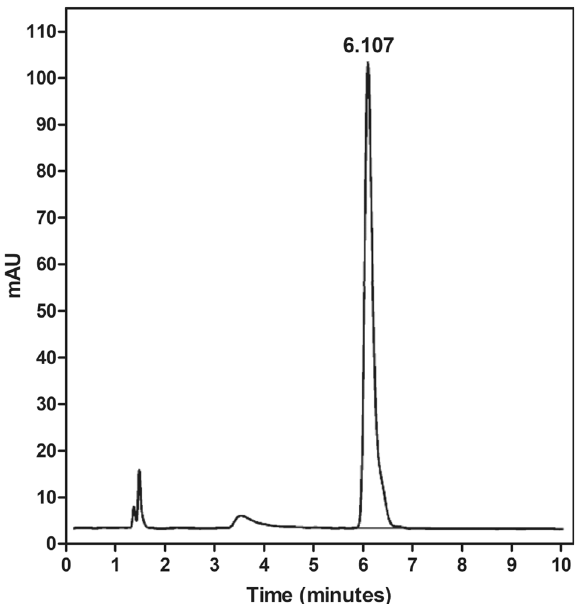
Fig. 1 HPLC chromatogram of methyl methacrylate (MMA) and peak at 6.017 min of retention